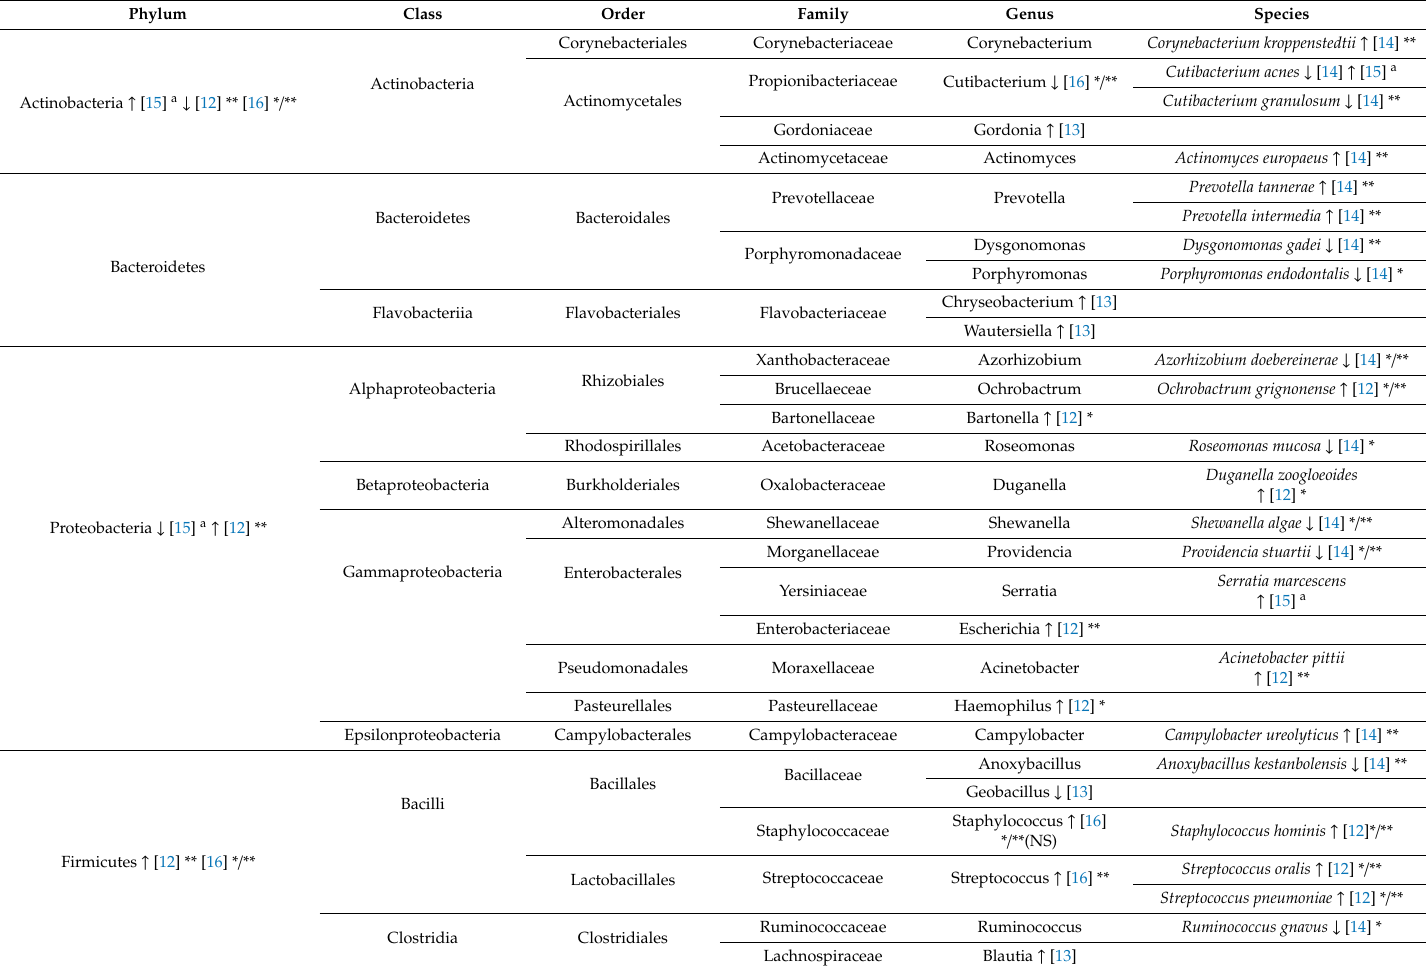
Table 4. Skin microbiome alterations in